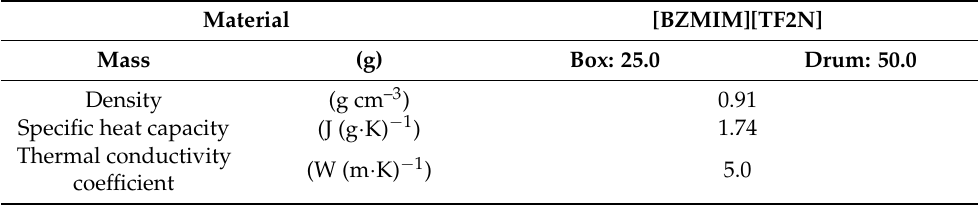
Table 2. Physical parameters of